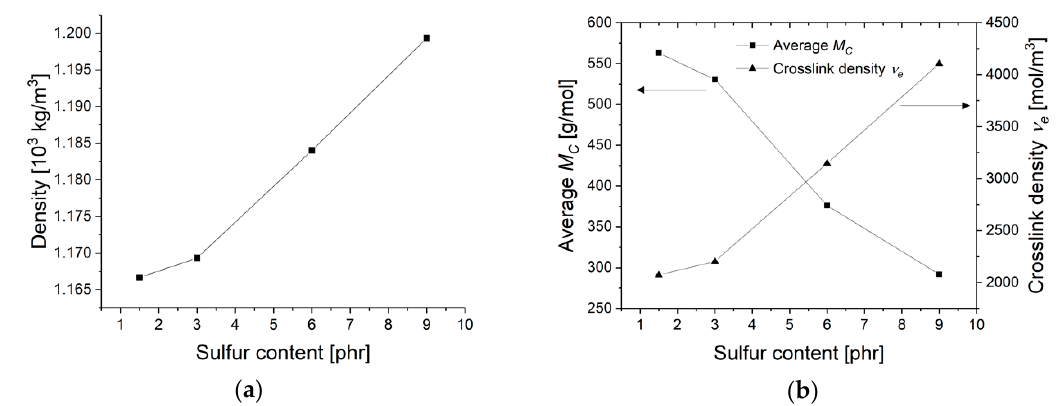
Figure 4. ( a ) density ρ ; ( b ) average molecular weight between crosslinks Mc and crosslink density ϑ e at various sulfur content.